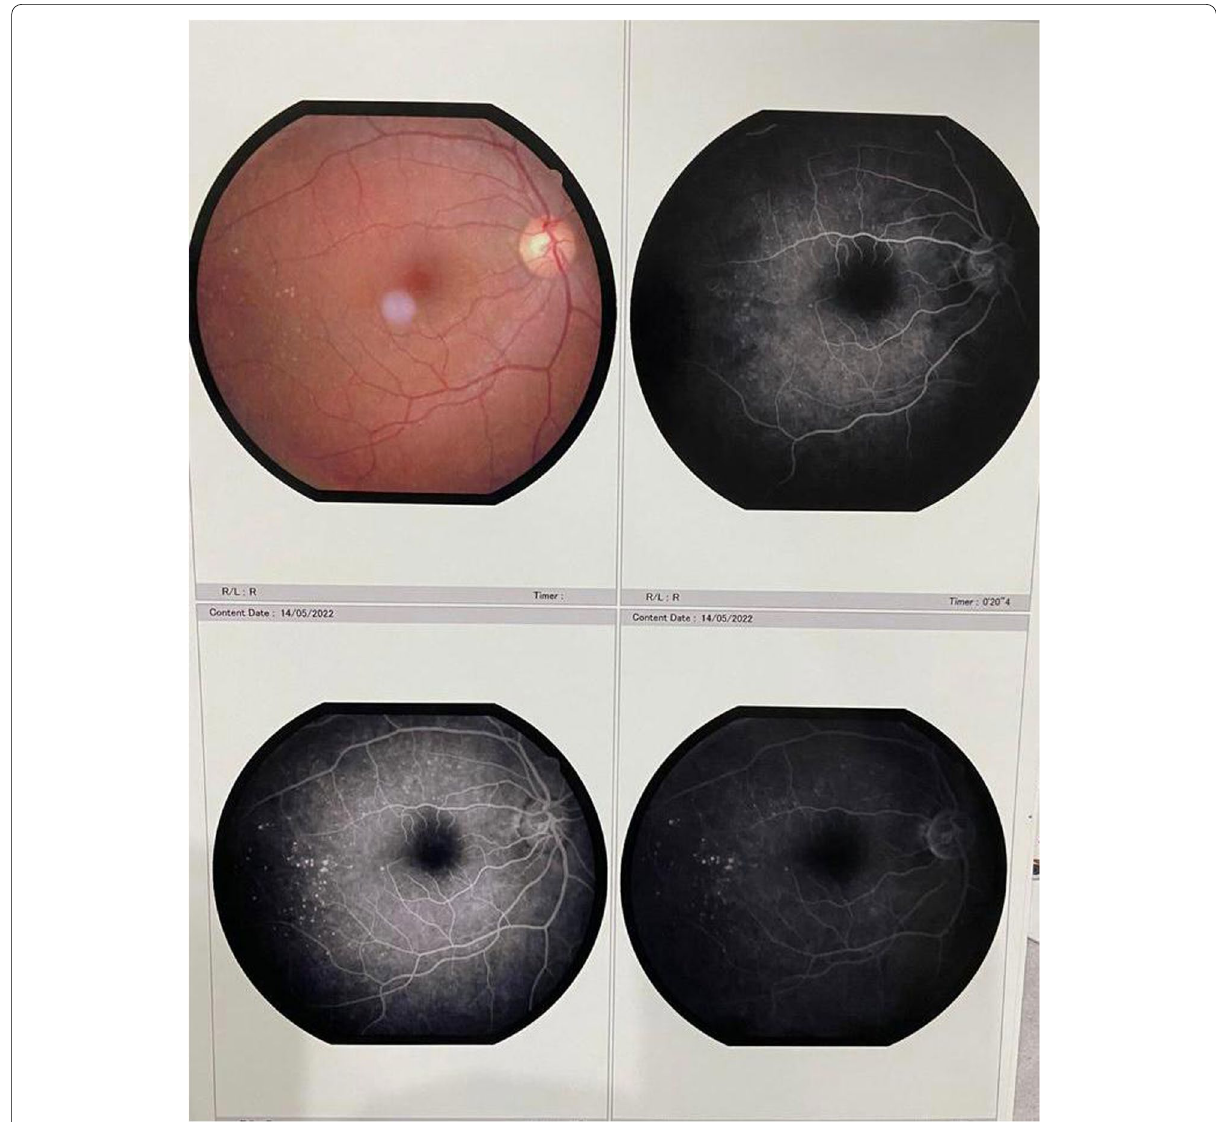
Fig. 5 Fundus fluorescein angiography of the right